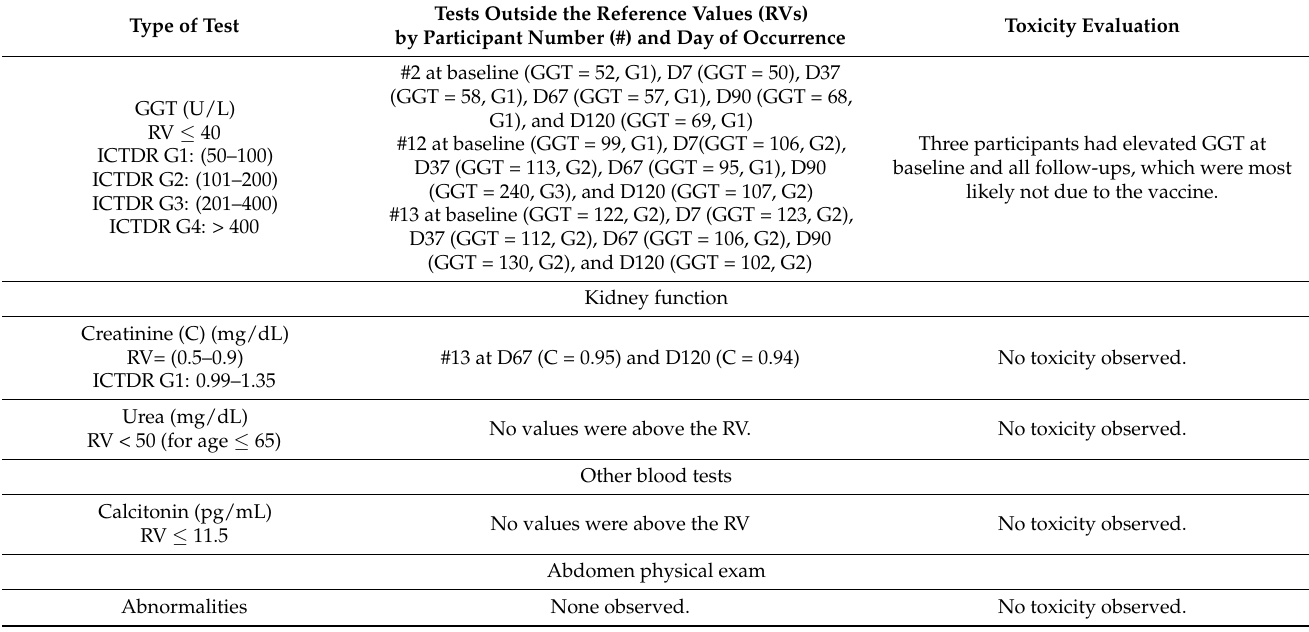
Figure 3. Levels of anti ‐ Sm14 antibody classes and cytokine production stimulated by vaccination. ( A ) ELISA antibody results. ( B ) Percentage of CD4 + T cells expressing combinations of IFN γ , TNF α , and IL ‐ 2 production in CD4+ T cells on days 0, 30, 90, and 120. The comparison of p ‐ values to baseline was performed for the vaccinated group (day 0); * p ‐ values at the 0.05 significance level. Sm14+GLA ‐ SE vaccination elicited robust cytokine responses. Cytokine profiles show increased TNF α , IFN ɣ , and IL ‐ 2 in vaccinated individuals on days 90 and 120.